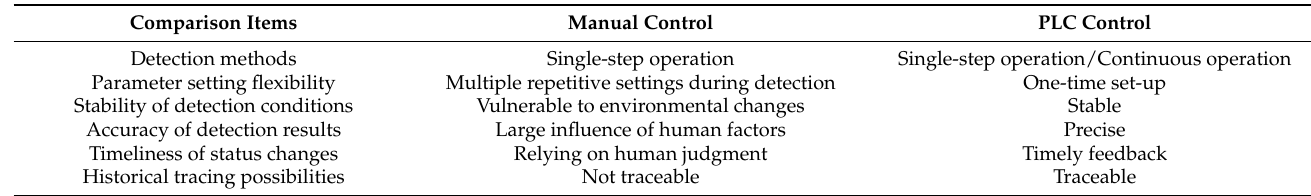
Table 2. Comparison of manual control and PLC